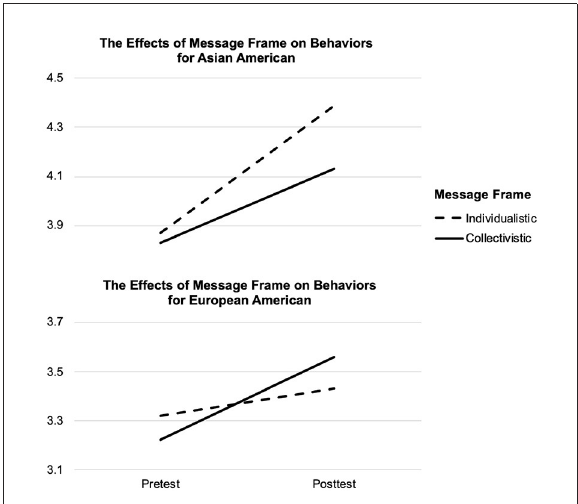
FIGURE2 The effects of message frame on behaviors by ethnicity.